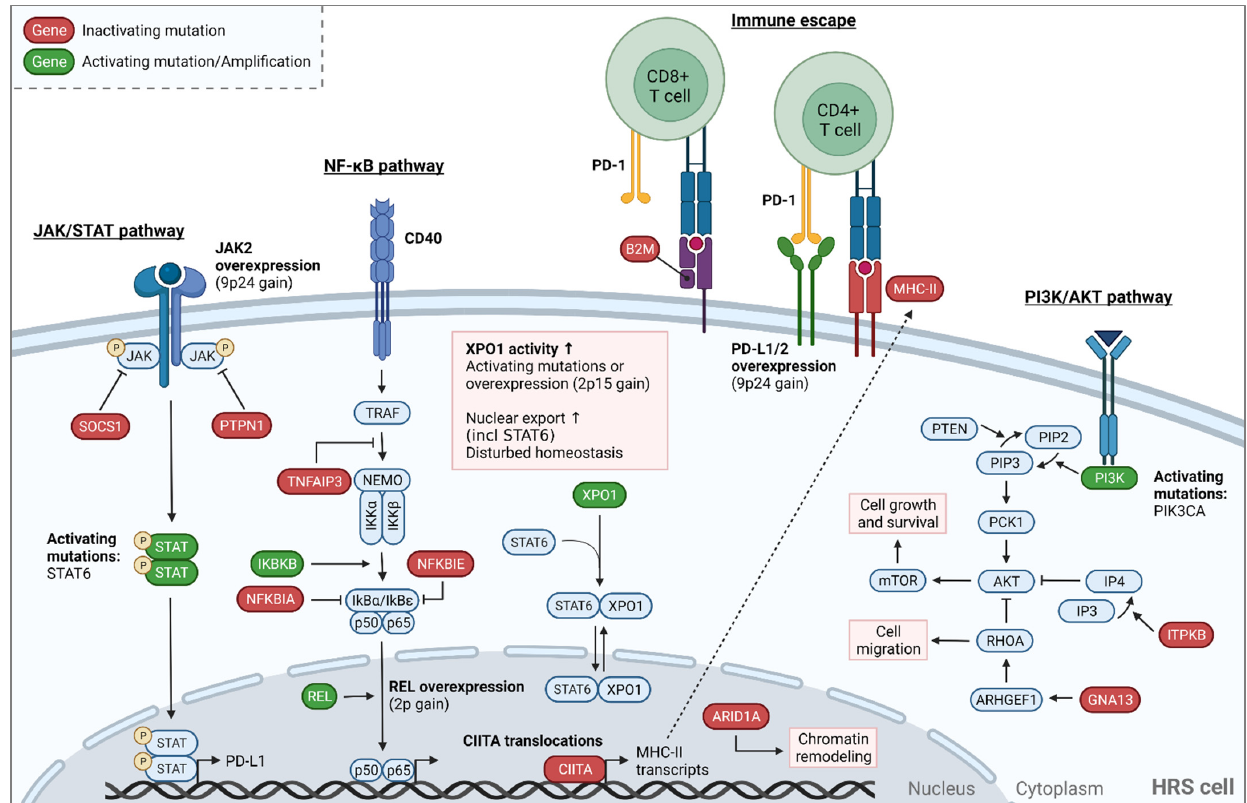
Figure 2. Schematic overview of the pathways affected by genetic alterations in classical Hodgkin lymphoma. The main affected pathways in the pathogenesis of cHL involve JAK/STAT, NF- κ B, PI3K/AKT and immune evasion, caused by inactivating mutations (in red), activating mutations (in green), translocations and overexpression due to gene amplifications. Nuclear–cytoplasmic (e.g., XPO1) transport and epigenetic regulation (e.g., ARID1A) may be disturbed in HRS cells, contributing to oncogenesis. Table 2. Overview of recurrent genetic aberrations in classical Hodgkin lymphoma and their effects. Gene